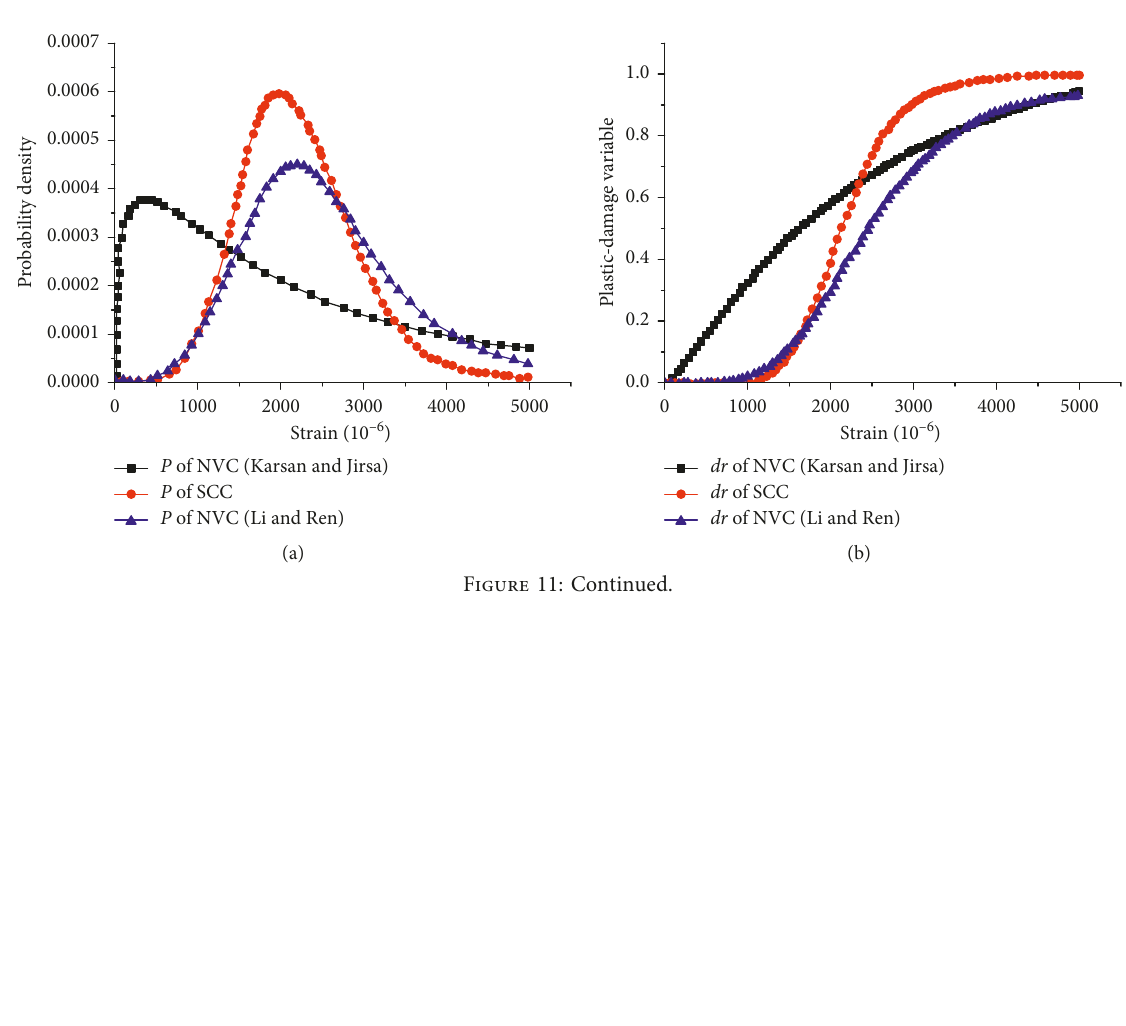
. (b) Stochastic degradation of elastic E